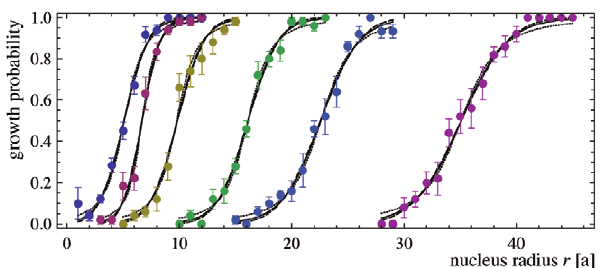
Figure 4. Growth probability of a circular nucleus as a function of the nucleus radius r in units of the linear size a of the membrane patches. The initial nucleus is bound in well 1 of the effective adhesion potential shown in fig. 1(b), and the surrounding membrane is boundin well 2 (see MonteCarlo snapshots in fig. 3). Thesix curves are from simulations with the rescaled depths u 2 ~ 0 : 1 , 0.105, 0.11, 0.115, 0.1175, and 0.12 of well 2 (from left to right). In all simulations, the rescaled depth of well 1 is u 1 ~ 0 : 125 , and the rescaled separation and width of the wells are z ba ~ 2 and z we ~ 0 : 5 . Each data point was obtained from averaging over 30 simulations. To extract the critical radius from a curve, we fit the curve with three different fit functions and determine the three radii r at which these fit functions attain the value 0.5. The critical radius r c is defined as the average of these three radii. For the six curves, we obtain the values r c ~ 5 : 10 , 6.70, 9.81, 16.12, 22.58, and 35.08 of the critical radius. The three fit functions are h 1 ( r ) ~ 1 = (1 z exp ½ { ( r { d 1 ) = d 2 (cid:2) ) (full lines), h 2 ( r ) ~ 0 : 5(1 z erf ½ ( r { d 1 ) = d 2 (cid:2) ) (dashed lines), and ffiffiffiffiffiffiffiffiffiffiffiffiffiffiffiffiffiffiffiffiffiffiffiffiffiffiffiffi q h 3 ( r ) ~ 0 : 5(1 z ( r { d 1 ) = ) (dotted lines). ½ d 2 z ( r { d 1 ) 2 (cid:2)